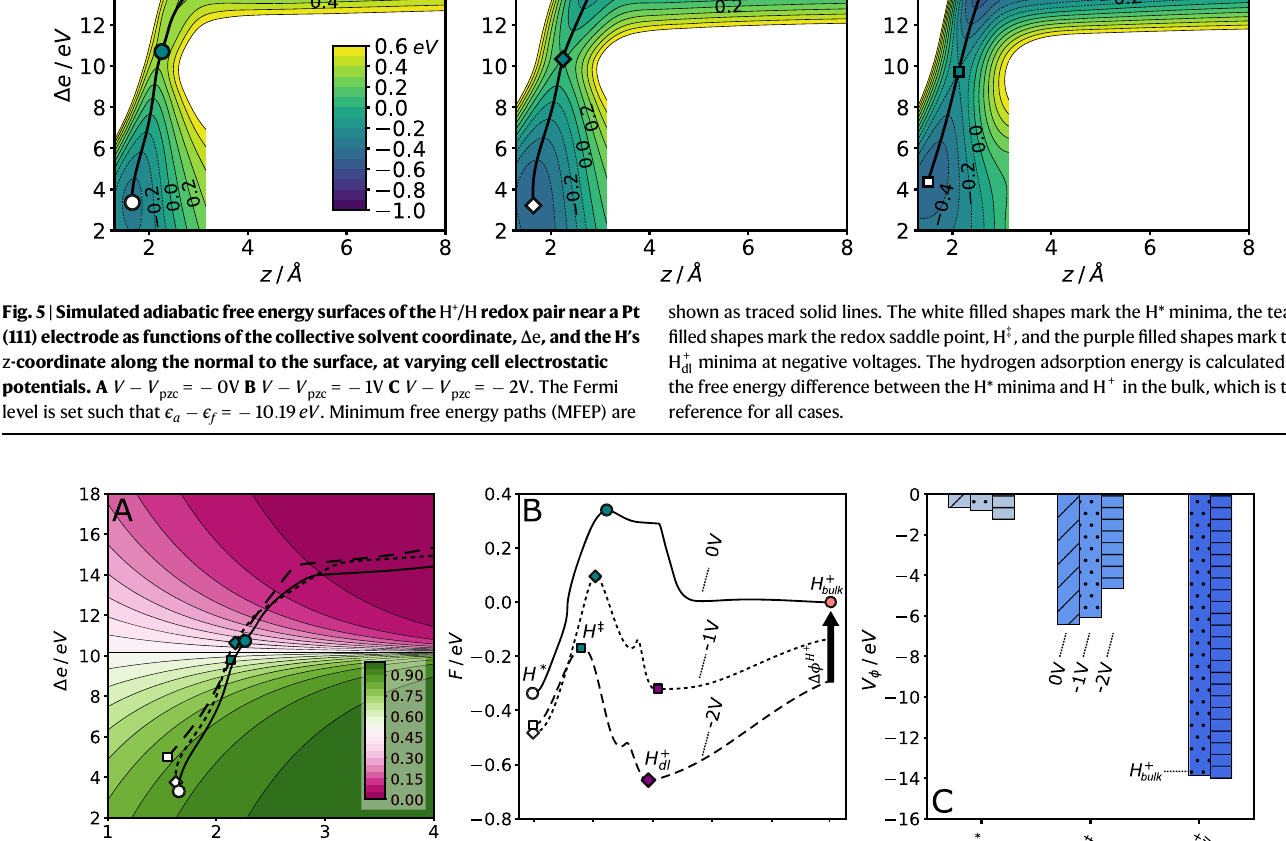
and dashed lines are the minimum free energy paths for the free energy surfaces corresponding to V (cid:2) V pzc =0V, (cid:2) 1V, (cid:2) 2V, respectively. B White shapes: Adsor- bedH(H*).Tealshapes:Redoxtransitionstates(H z ).Purpleshapes:Protonminima in the doublelayer (H + dl ). Pink circle: bulkproton referencestate (H + bulk ). C the bars (cid:1) (cid:3) correspondto0V(diagonalhatches), − 1V(dots),and − 2V(horizontalhatches). V ϕ for the reference, H + bulk , is shown for comparison to H + dl .